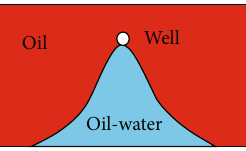
Figure 2: Seepage